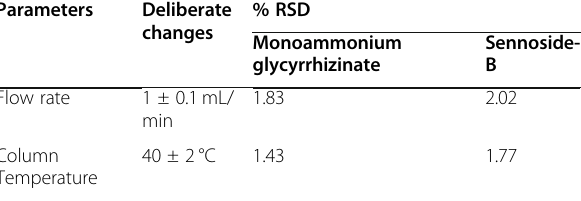
Table 9 Results of robustness study